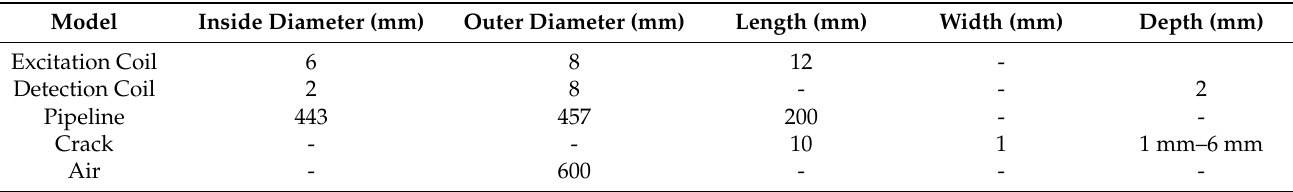
Figure 3. Simulation model of the balanced-field electromagnetic technique. Table 1. Dimensional parameters of the simulation model.